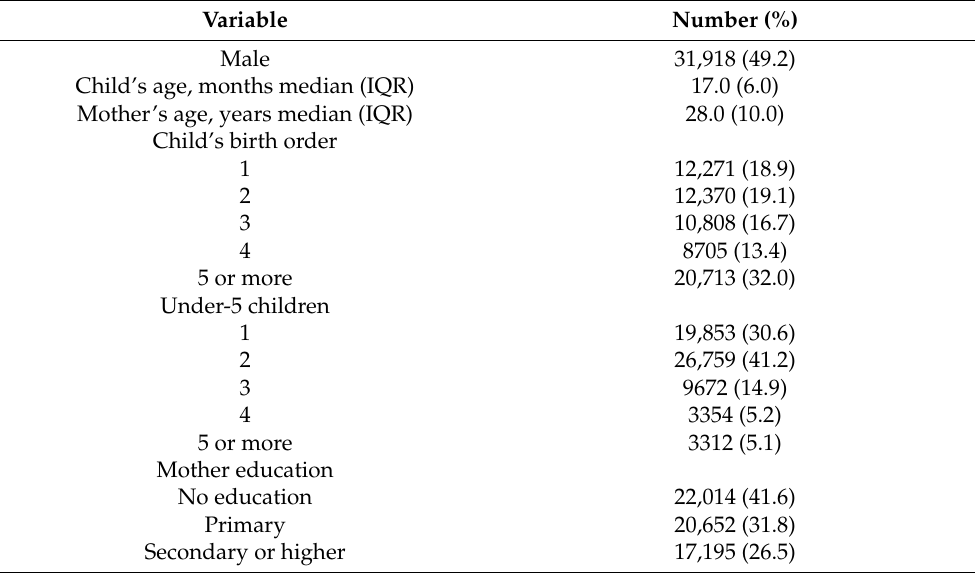
Figure 2. Prevalence in non-vaccination for polio across African countries. Table 1. Summary of pooled sample characteristics of the Demographic and Health Surveys data in Africa, 2010–2018.